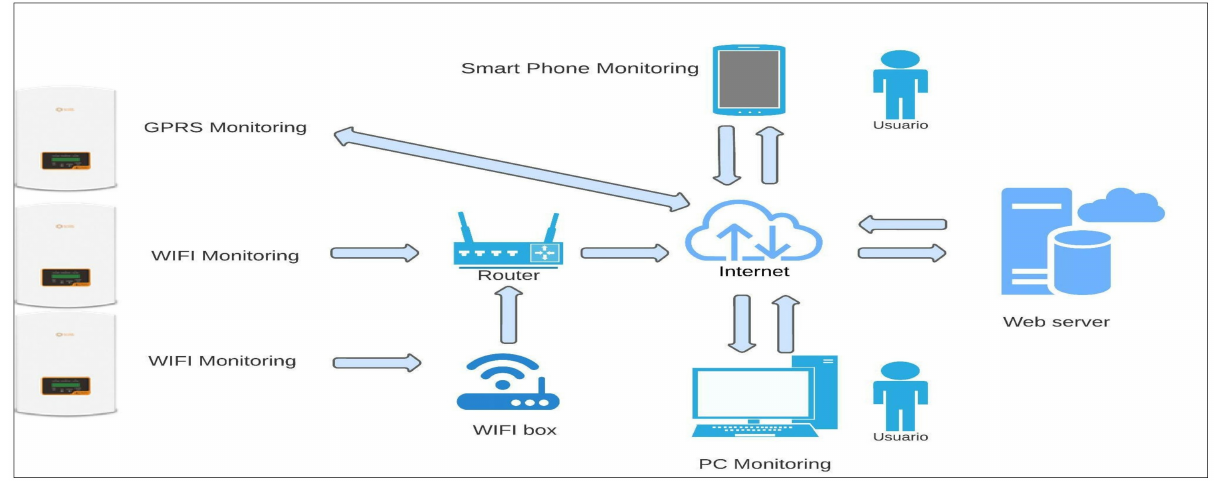
Figure 12. Schematic real time monitoring of an On Grid-PV connected system